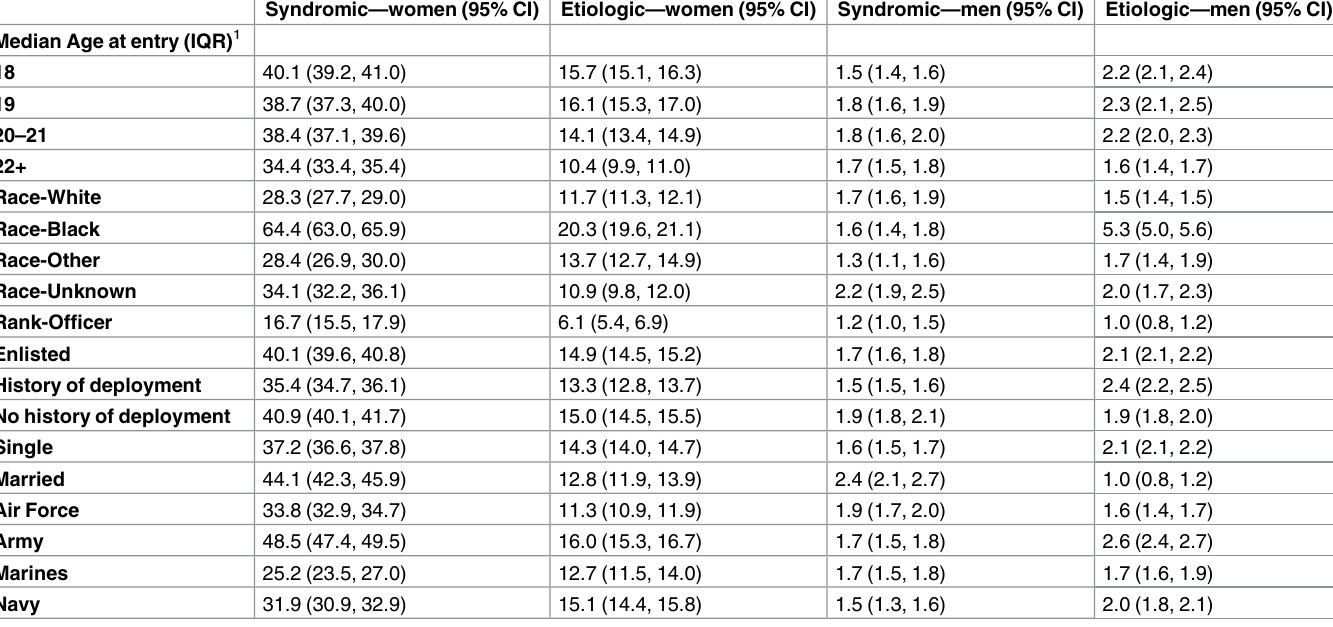
Table 3. Incident rates (per 1,000 person-years) of sexually transmitted infections for women and